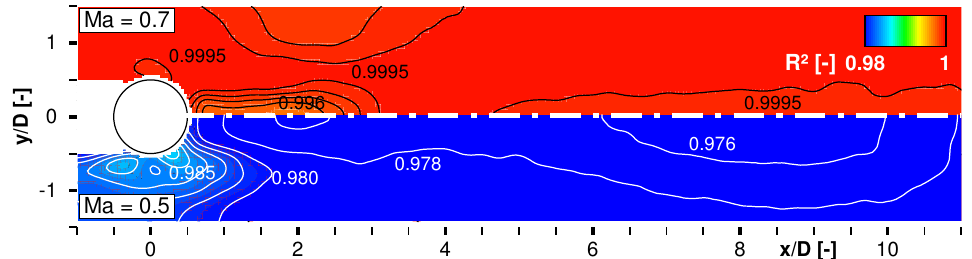
Figure 6. Determination coefficient R 2 of linear fit T TSP -vs.- q (cid:48)(cid:48) temperature T aw compared for Ma ∞ = 0.7 and Ma ∞ =